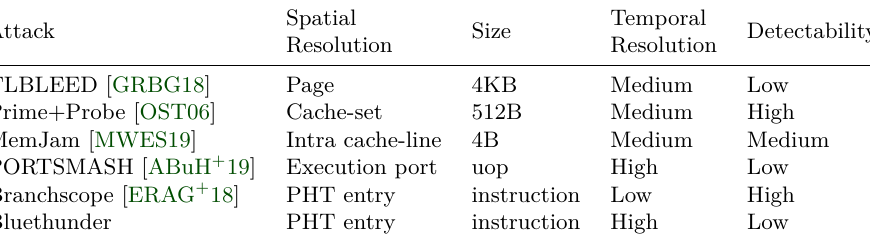
Table 6: Comparison between Bluethunder and other attacks against